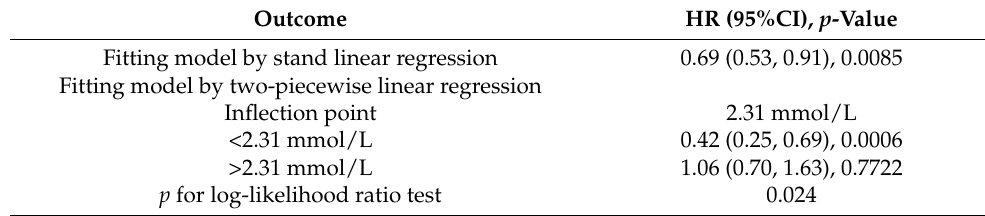
Figure 1. Curve fitting between LDL and mortality. Adjusted for age, sex, CHD, arrhythmia, de- mentia, treatment strategy. The red line is the fitting curve, and the blue lines are 95%CI. Table 3. Nonlinearity of LDL and mortality. Table 3. Nonlinearity of LDL and mortality.